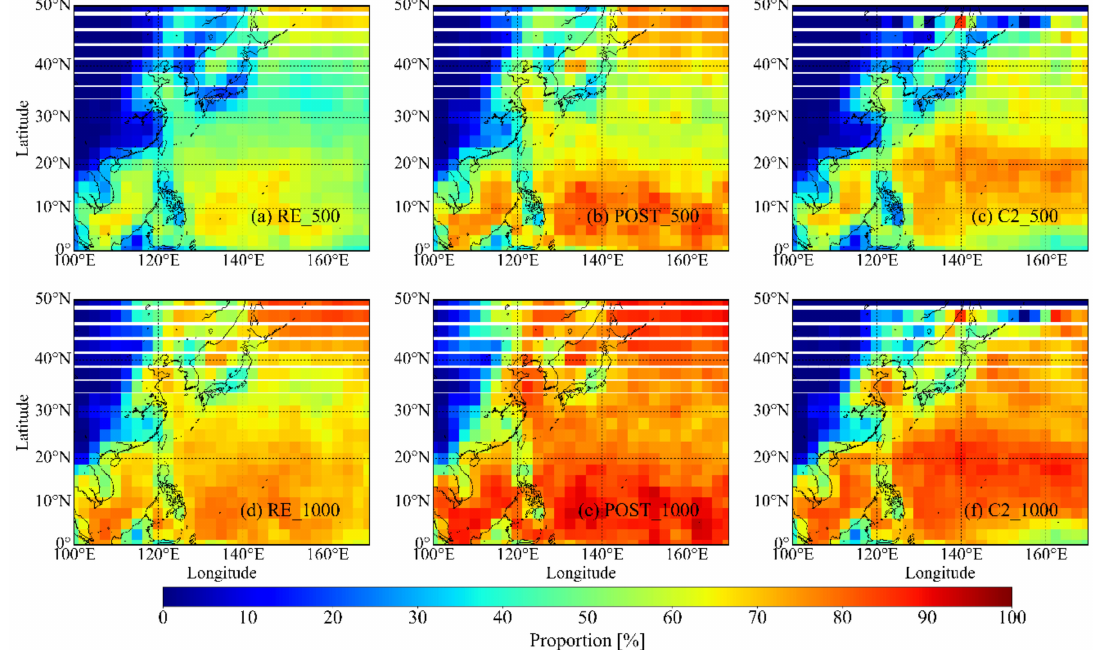
Figure 4. Proportion of reprocessed COSMIC (2007–2013, RE), post-processed COSMIC (2014–2018, POST), and COSMIC-2 profiles (2020, C2) that had the lowest detection heights below 0.5 km ( top ) and 1.0 km ( bottom